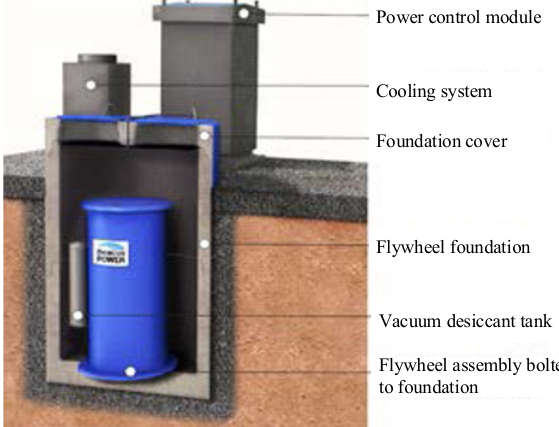
Fig. 6. Cutaway of flywheel in foundation of beacon